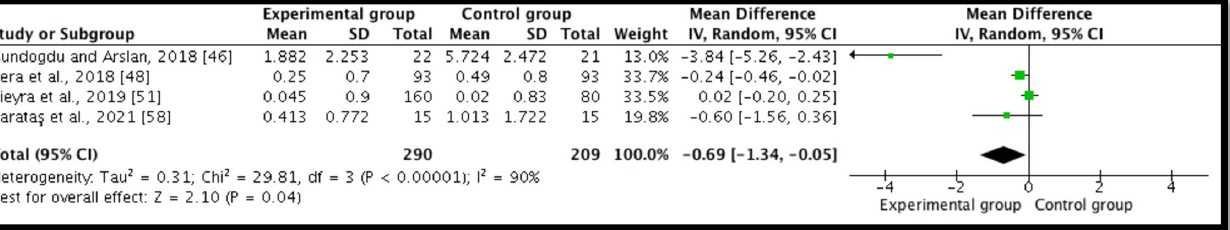
Figure 6. Forest plot comparing postoperative pain between the experimental group (intracanal cryotherapy) and the control group (room temperature) at 72 h.